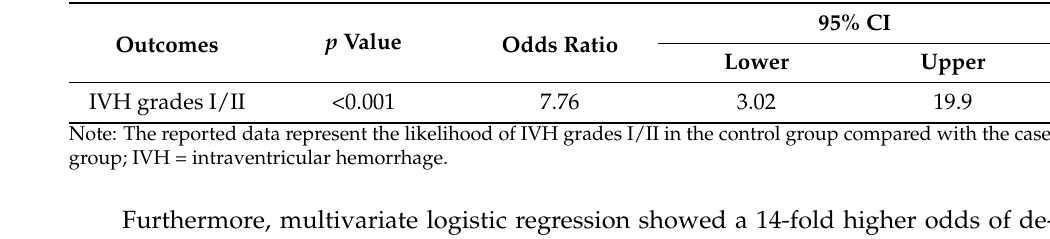
Table 10. The likelihood of infants born between 30 and 34 WG included in the control group to develop intraventricular hemorrhage grades I–II.